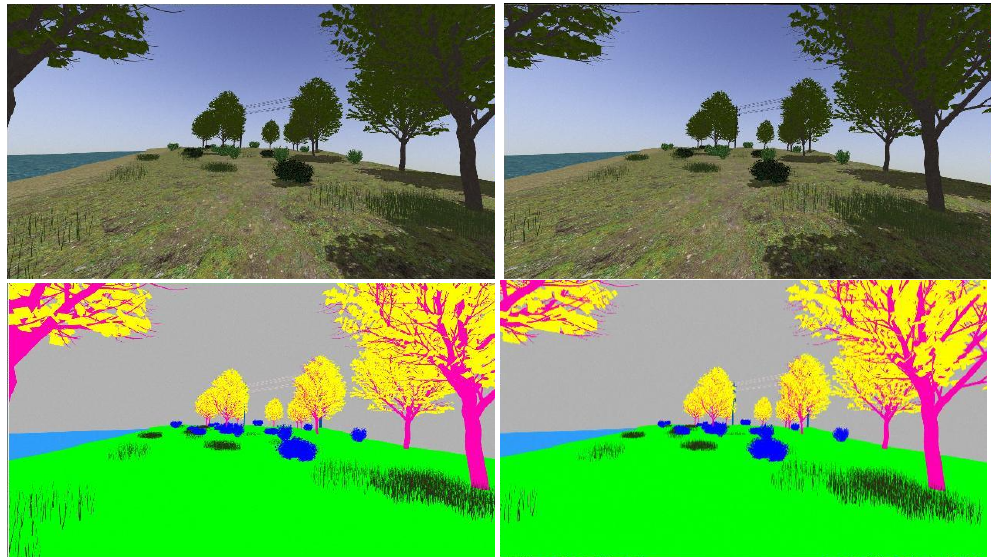
Figure 18. Realistic ( up ) and tagged ( down ) stereo image pairs ( left-right ) taken from the lake environment.